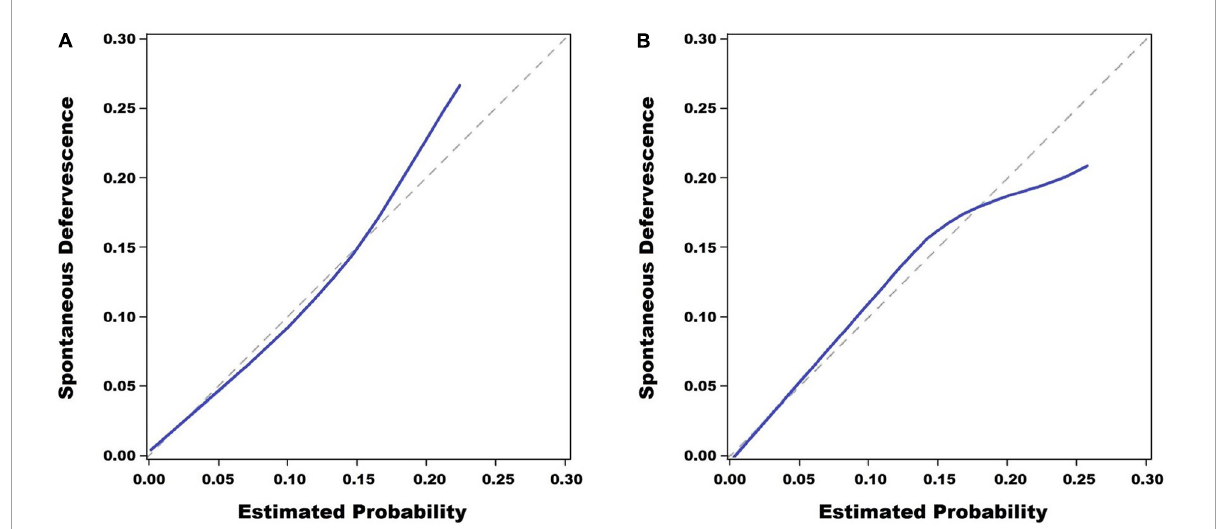
FIGURE3 Calibration plots. The scoring system for the prediction of spontaneous defervescence showed a good fitting degree in the Hosmer–Lemeshow test in the training set ( P = 0.559) (A) and it also showed a good fitting degree in the validation set ( P = 0.704) (B)